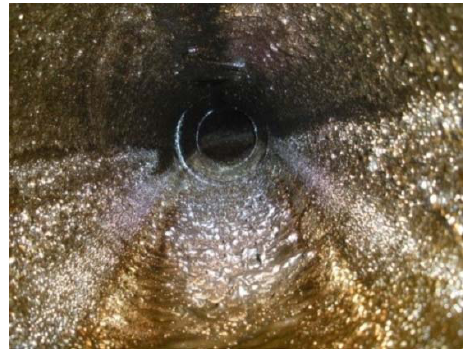
Figure 11. Illustration of pipeline sections with wax deposition in the field.